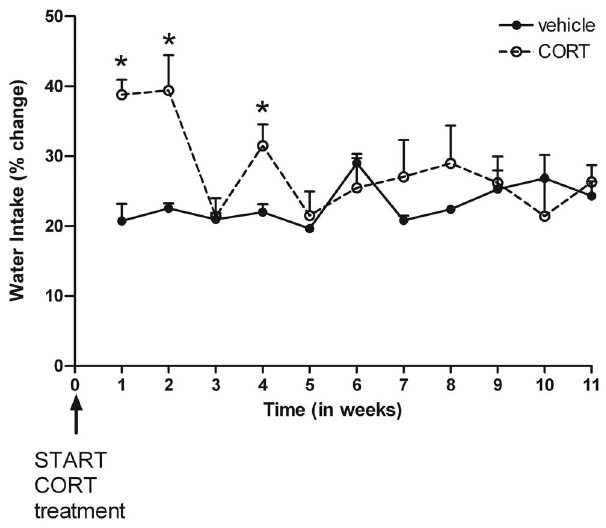
Figure 5. Effects of corticosterone (CORT) administration via the drinking water upon body weight (mean % change compared to body weight prior to start of treatment + S.E.M.) during the 12 week treatment period. Significant increased body weights in the CORT group are denoted with * (P , 0.01); (*) trend.